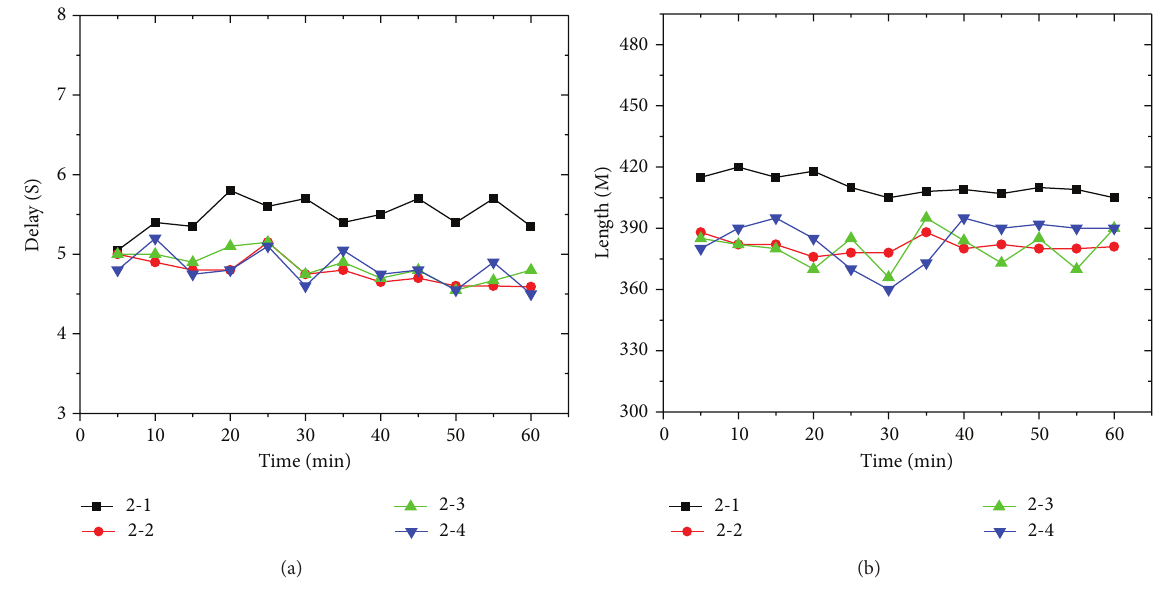
Figure 20: Contrast of delay and travel length (number